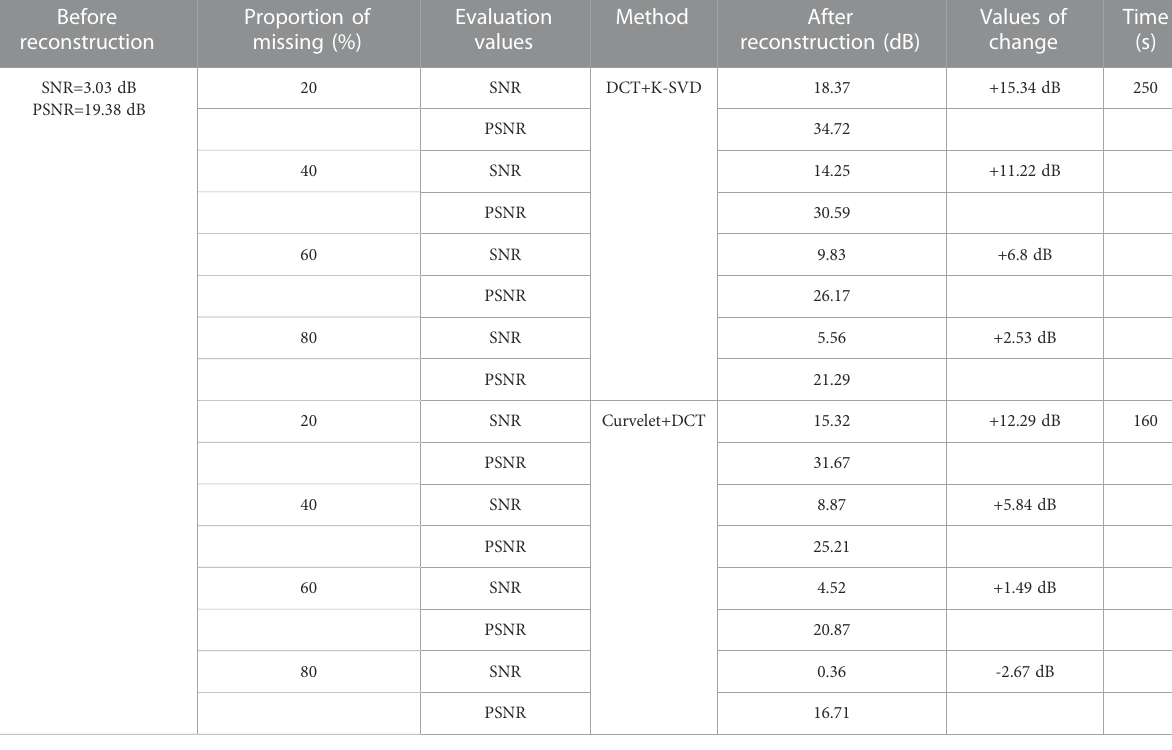
TABLE 2 Evaluation values for different missing. Before reconstruction